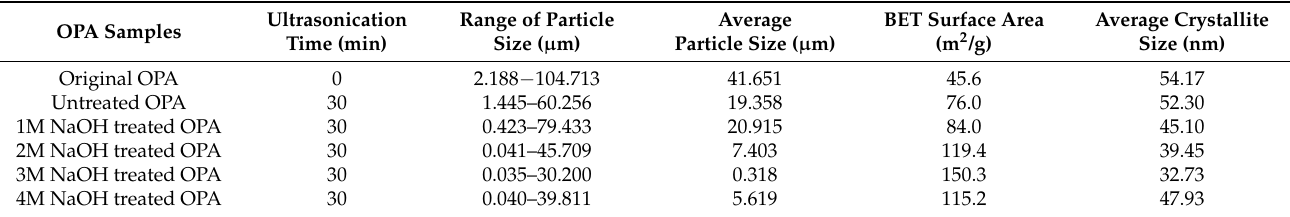
Figure 4. Change in particle size of OPA treated with NaOH at different concentrations followed by ultrasonication for 30 min: ( a ) particle size distribution and ( b ) the maximum particle size, average particle size and minimum particle size of treated OPA. Table 5. Average particle size, range of particle size and BET surface area of untreated OPA and treated OPA with NaOH at different concentrations followed by ultrasonication for 30